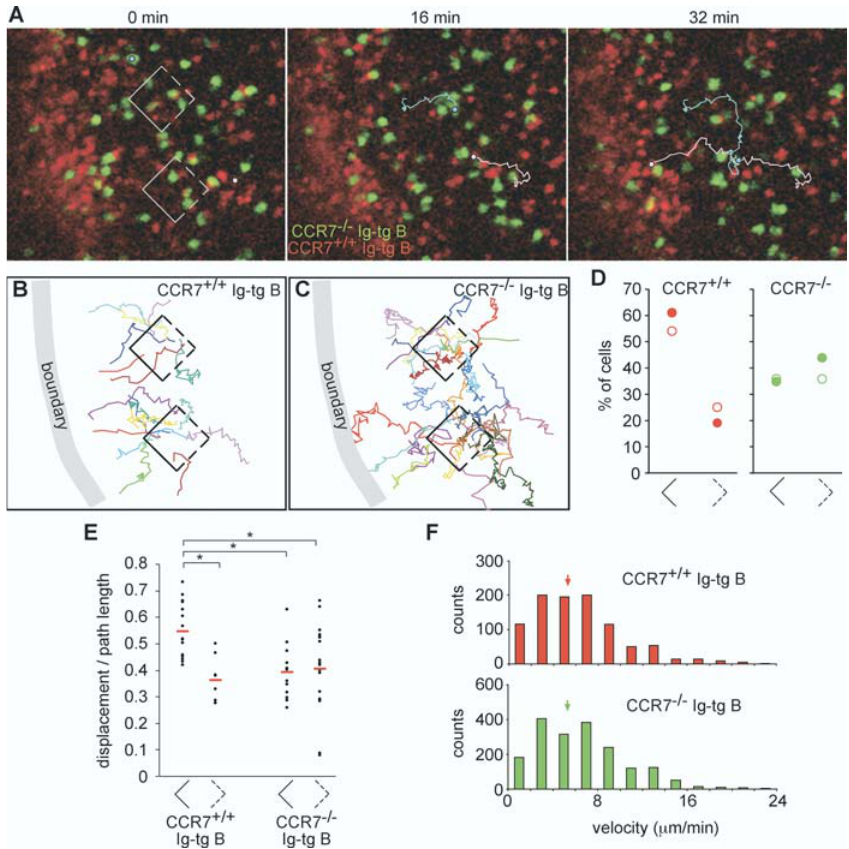
Figure 4. Antigen-Engaged CCR7 (cid:1) / (cid:1) B Cells Fail to Show Directional Migration toward the Follicle–T Zone Boundary (A) Time-lapse images of HEL-engaged CCR7 (cid:1) / (cid:1) (green) and CCR7 þ / þ (red) Ig-tg B cells in an inguinal lymph node. The 0-min image is ; 3.5 h after antigen exposure (see Video S4). Square boxes indicate regions used for directionality analysis, shown in (B). A CCR7 (cid:1) / (cid:1) Ig-tg B cell (light blue circle and line) and a CCR7 þ / þ Ig-tg B cell (pink circle and line) are traced as examples. (B and C) Tracks of antigen-engaged CCR7 þ / þ (B) and CCR7 (cid:1) / (cid:1) (C) Ig-tg B cells originating from 30- l m follicular cubes, analyzed as described in Figure 2. Tracks cover 3–17 min for CCR7 þ / þ cells and 3–22 min for CCR7 (cid:1) / (cid:1) cells. (D) Dot plot showing the percentage of cells that moved across the solid or dashed sides of the cubes. Filled symbols correspond to the data shown in (A–C) and Video S4, open symbols correspond to data obtained in a second time-lapse movie collected 2.5–3.5 h after antigen injection. The cubes were located approximately 20–80 l m from the site of accumulation of CCR7 þ / þ Ig-tg B cells. (E) The dot plots show ratios of the displacement to the path length of 8-min tracks of antigen-engaged CCR7 þ / þ or CCR7 (cid:1) / (cid:1) Ig-tg B cells originating from the cubes described in (A–D). The left and right plots for each cell graph are the data of tracks that cross the solid and dashed sides of the cubes, respectively. A total of 74% of wild-type B cells and 81% of CCR7 (cid:1) / (cid:1) B cells that crossed the sides of the cubes could be tracked for 8 min. The means of each data group are shown as red bars. *, p , 0.01. (F) Velocity distribution data for CCR7 (cid:1) / (cid:1) Ig-tg B cells (green, n = 27) and CCR7 þ / þ Ig-tg B cells (red, n = 40) tracked 2.5–4.2 h after antigen injection. The data are pooled from two time-lapse movies. Medians are indicated by